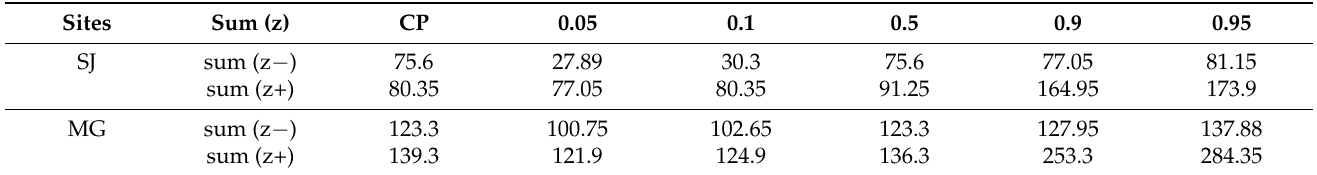
Figure 5. Threshold Indicator Taxa Analysis (TITAN) of micro-eukaryotic assemblage response to the amount of precipitation (mm). Change point (black and white circles) and 95% confidence limits (hori- zontal lines) of significant indicator species at ( a ) SJ ( n = 13, p < 0.05, purity > 0.95, and reliability > 0.95 for 500 bootstrap replicates) and ( b ) MG ( n = 14, p < 0.05, purity > 0.95, and reliability > 0.95 for 500 bootstrap replicates) sites. Black and white circles indicate the change points. Circle diameter is proportional to the magnitude of the response (z scores). z − : Negatively associated taxa (z − ) with increased precipitation and z+: Positively associated taxa (z+) with increased precipitation. Table 5. TITAN assemblage-level thresholds estimated from the response of micro-eukaryotes to the amount of precipitation (mm). Sum(z − ) and sum(z+) indicate a decrease ( − ) or increase (+) along the gradient of the precipitation; CP indicates the assemblage change point; 5, 10, 50, 90, and 95% are bootstrap quantile